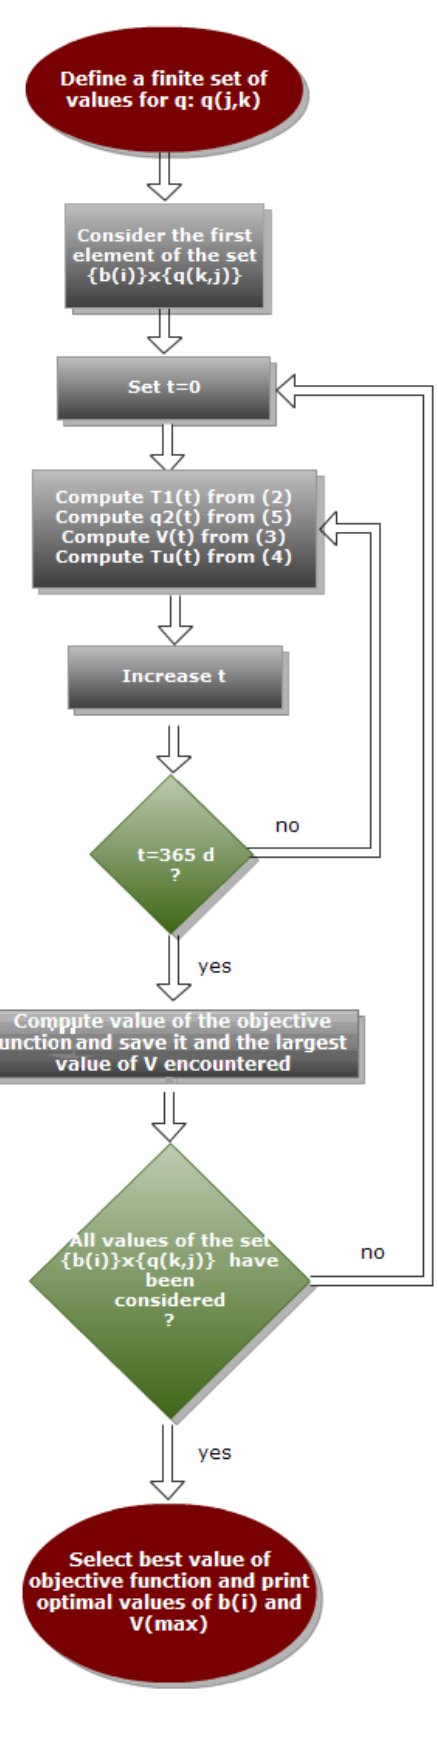
Figure 10. Flow chart of the optimisation